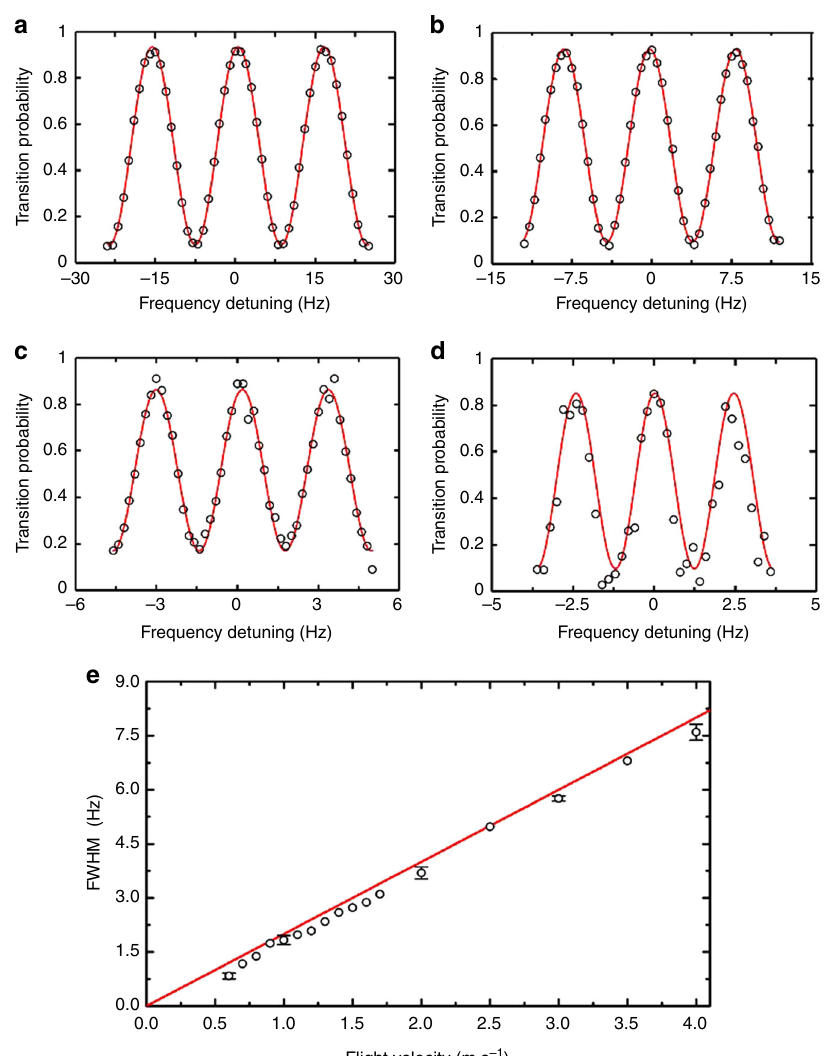
Fig. 3 Ramsey fringes with different launch velocities. Central Ramsey fringes of the space CAC with a launch velocity of a 4.0m s − 1 , b 1.0m s − 1 , c 0.8m s − 1 , and d 0.6 m s − 1 , respectively, corresponding to the FWHM of central fringe 7.3, 1.8, 1.4, and 0.9 Hz. Red lines are sinusoidal fi ts. e Dependence of FWHM of the central Ramsey fringes on fl ight velocity. Red line represents calculated result; black circles represent measured results. Each error bar is the standard deviation calculated from eight